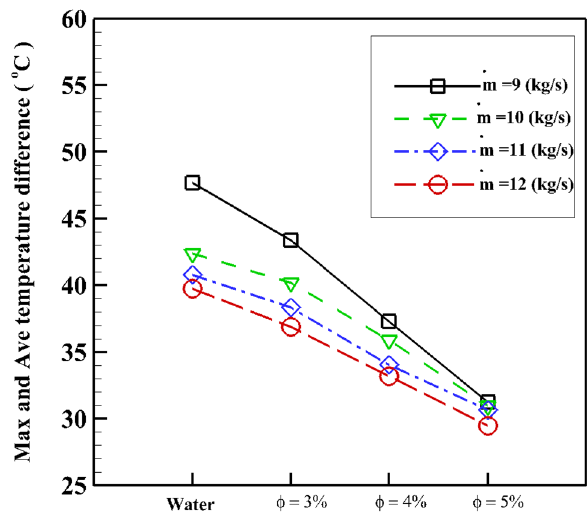
Fig. 15 Maximum temperature on WCP hot-side at constant flow rates vs concentration